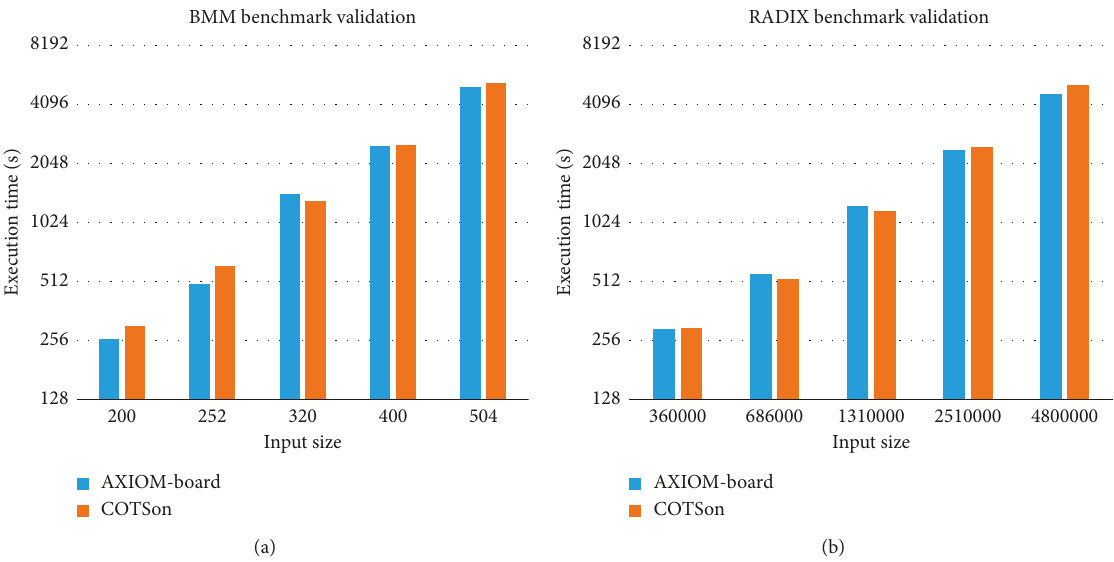
Figure 17: Validation of the execution time of the simulator against the AXIOM board. We used the blocked matrix multiplication (BMM) and Radix-Sort benchmarks with different sizes (weak scaling). The results on the actual board match closely the